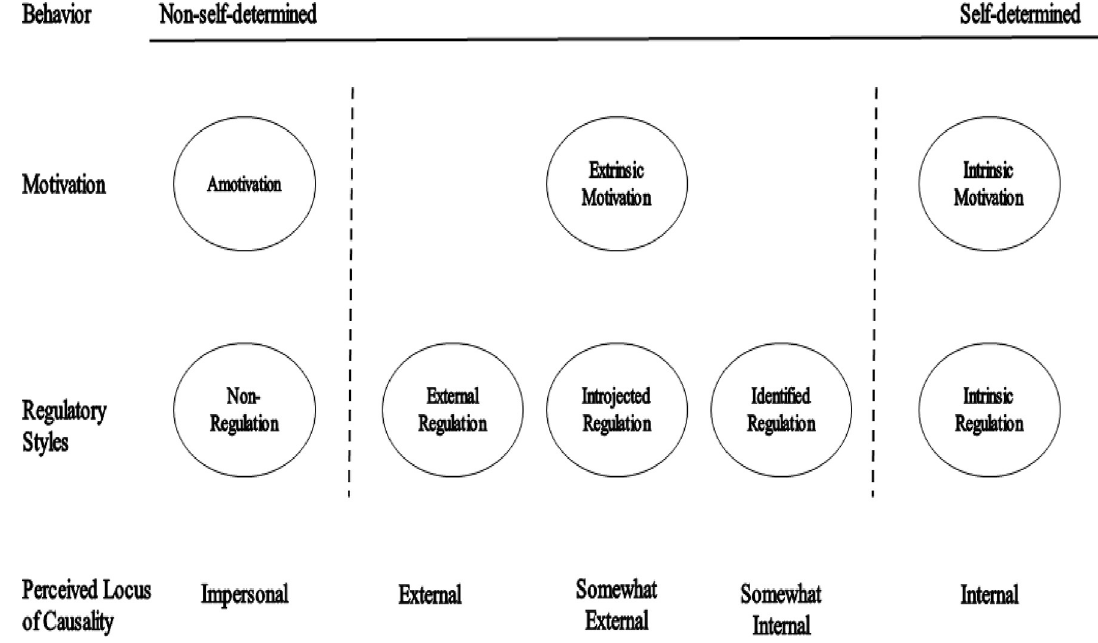
Fig 1. The taxonomy of regulatory styles. Adapted from Ryan & Deci